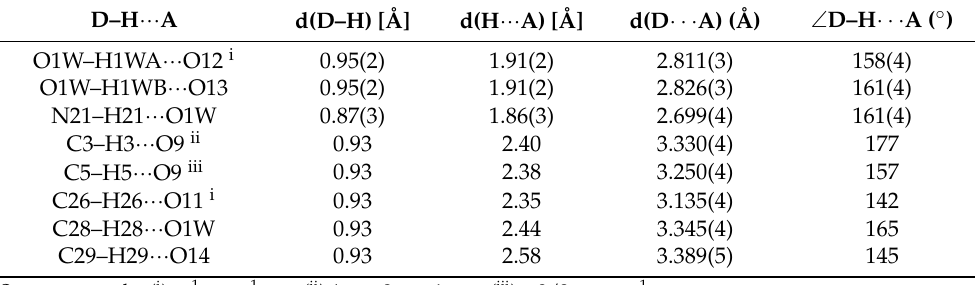
Figure 2. Crystal packing of [VOO(dipic)](2-phepyH) · H 2 O viewed along b -axis. Table 2. Hydrogen bonds geometry in the crystal of [VOO(dipic)](2-phepyH) · H 2 O.